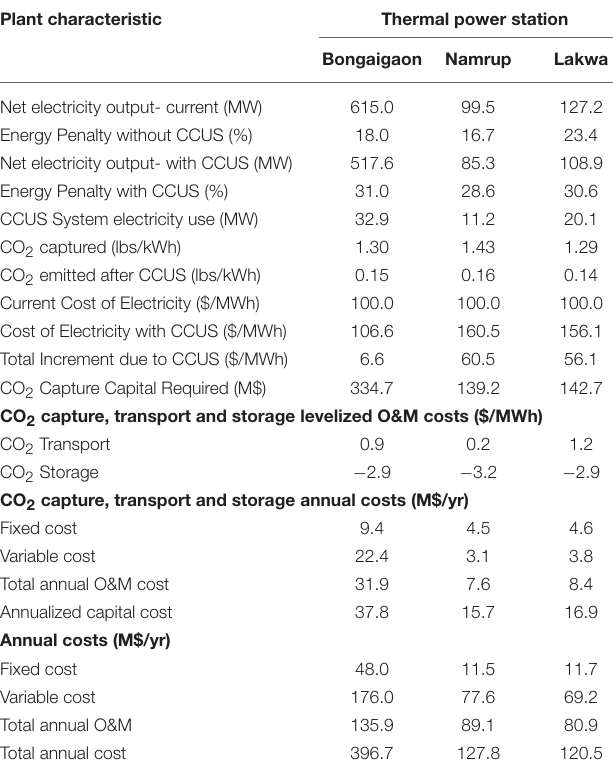
TABLE 3 | Economic comparisons of incorporating CCUS at various assam based thermal power plant stations (all results reported in 2017 USD). Plant characteristic Thermal power